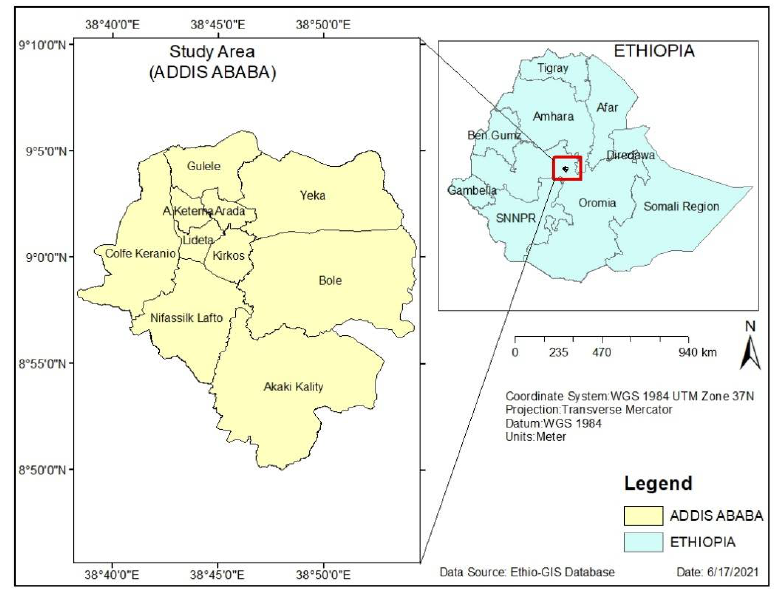
Figure 1. Location Map of the Study Area.